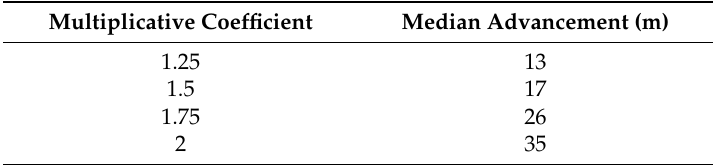
Table 3. Median advancement inland of the interface with variable incoming flux.